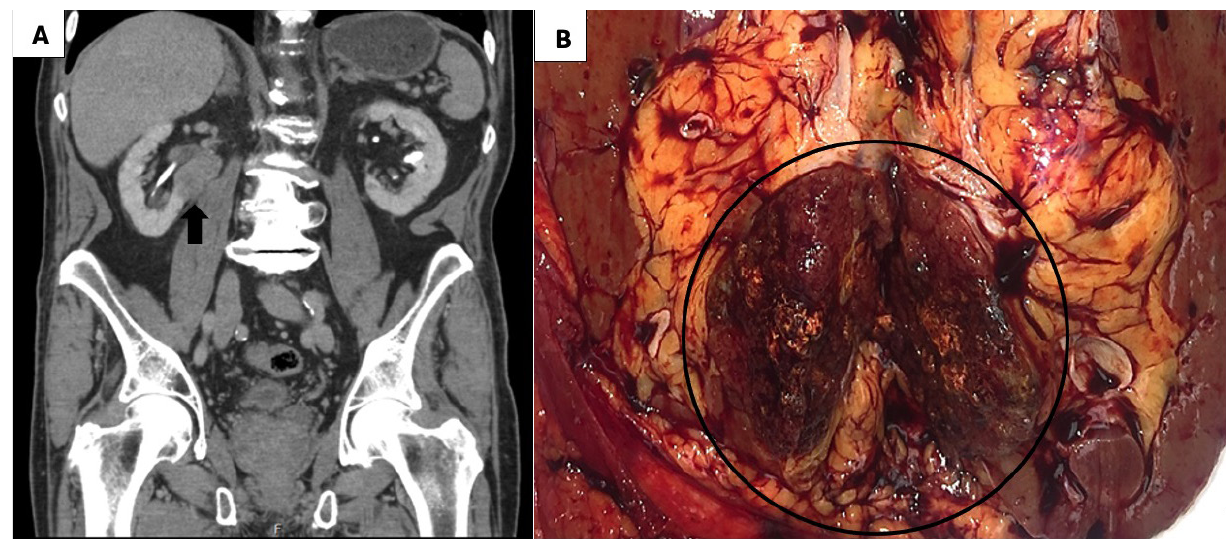
Figure 1: The Computerized Tomography (A) and the gross photograph (B) of the renal mass showing a well circumscribed tan brown mass in the right kidney extending into the renal